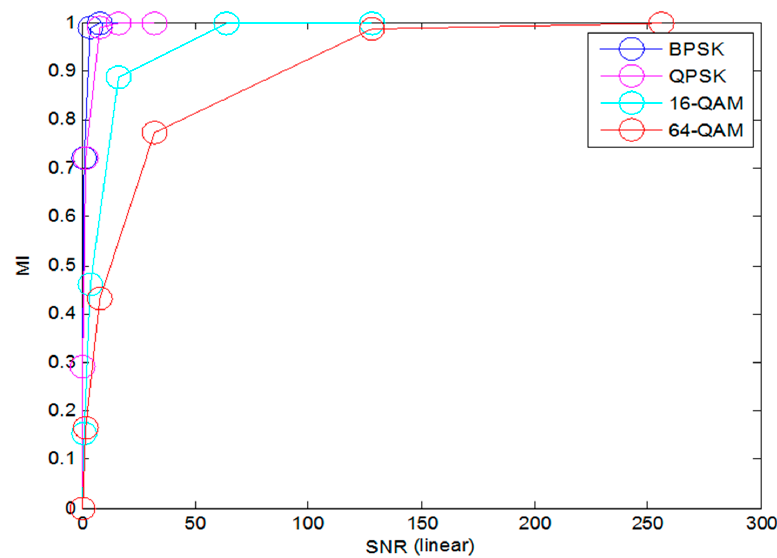
Figure 11. SNR-to-MI tables for modulation